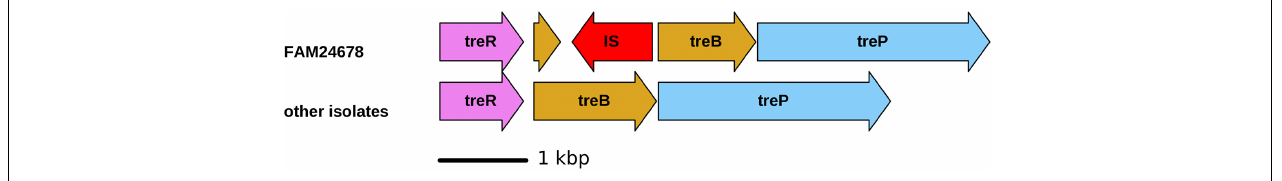
FIGURE 1 | Schematic illustration of the trehalose operon of FAM24678 (not fermenting trehalose) and the other 10 cheese isolates (fermenting trehalose). TreR , HTH-type transcriptional regulator; treB , PTS system trehalose-specific EIIBC component; treP , trehalose 6-phosphate phosphorylase; IS, insertion sequence.